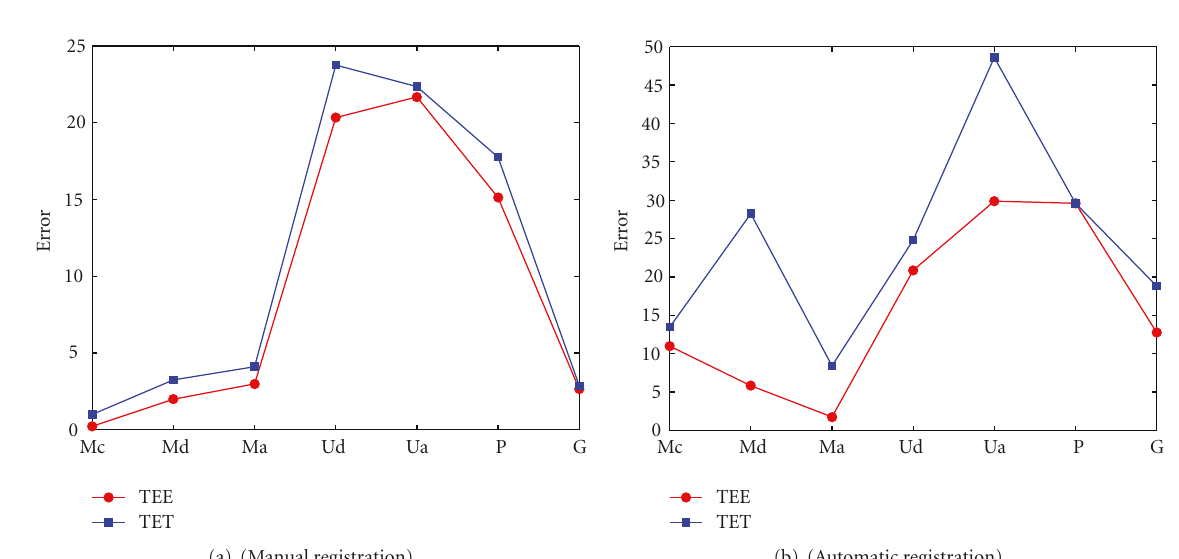
Figure 6: Verification results by fusing the LDA- and PCA-based classifiers using